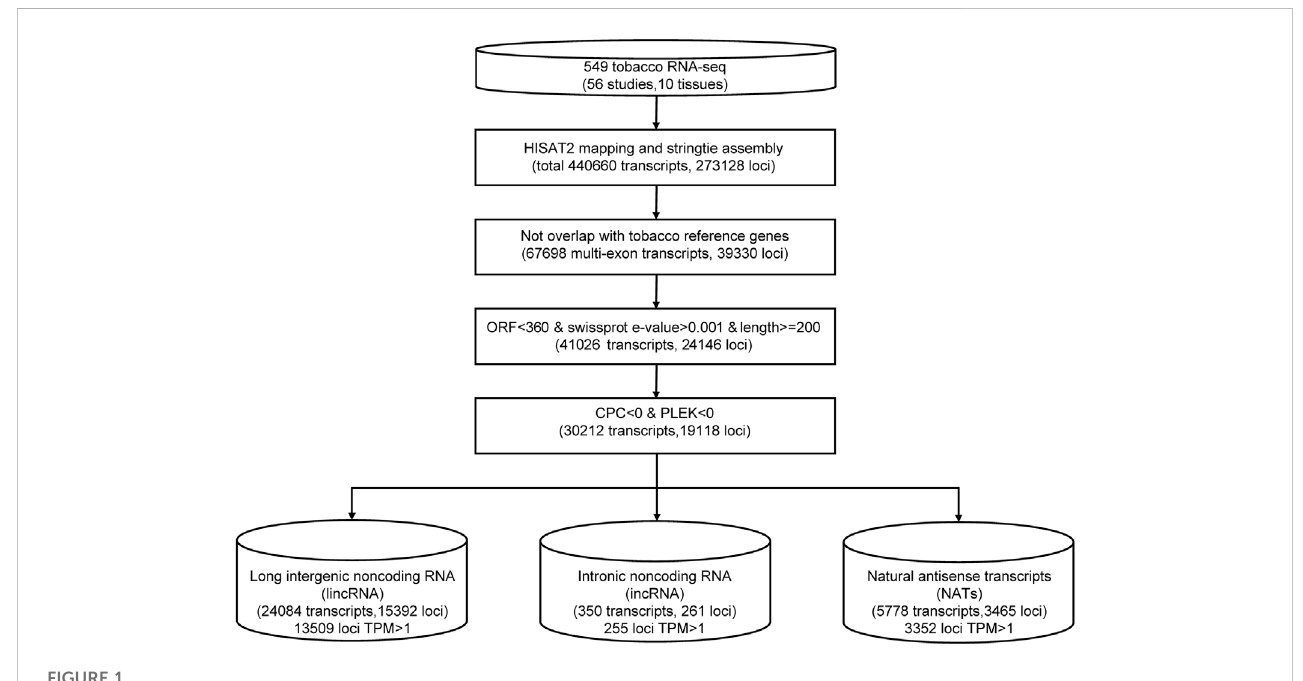
FIGURE 1 The pipeline for lncRNA identi fi cation in